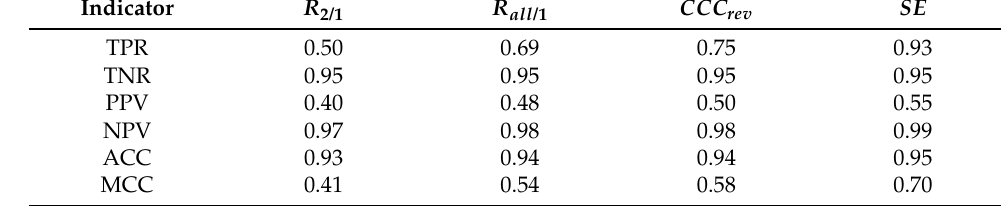
Table 5. Metric statistical indicators for hypothesis 1 .